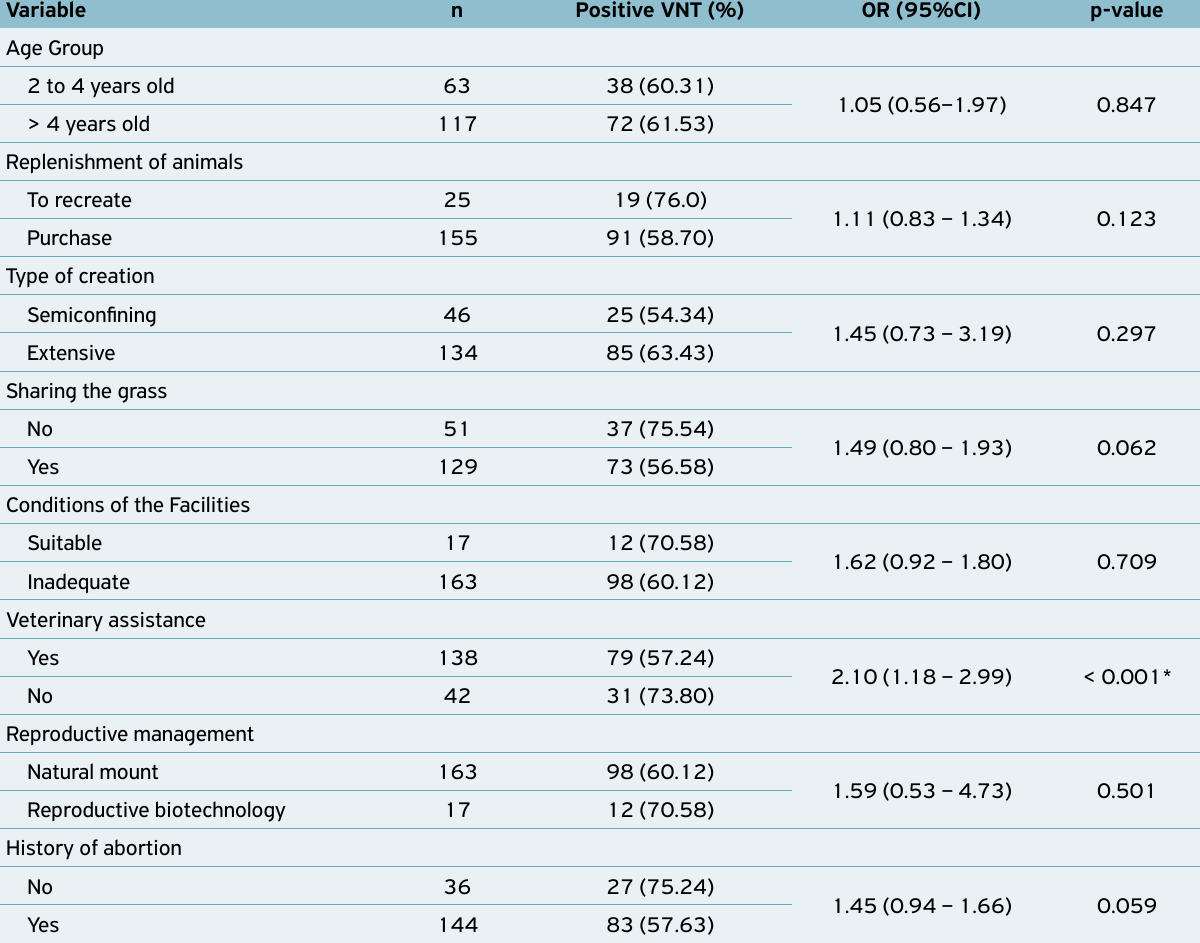
Table 2. Risk factors associated with bovine alphaherpesvirus type 1 infection in dairy farms in the municipality of Senador Guiomard, Acre,